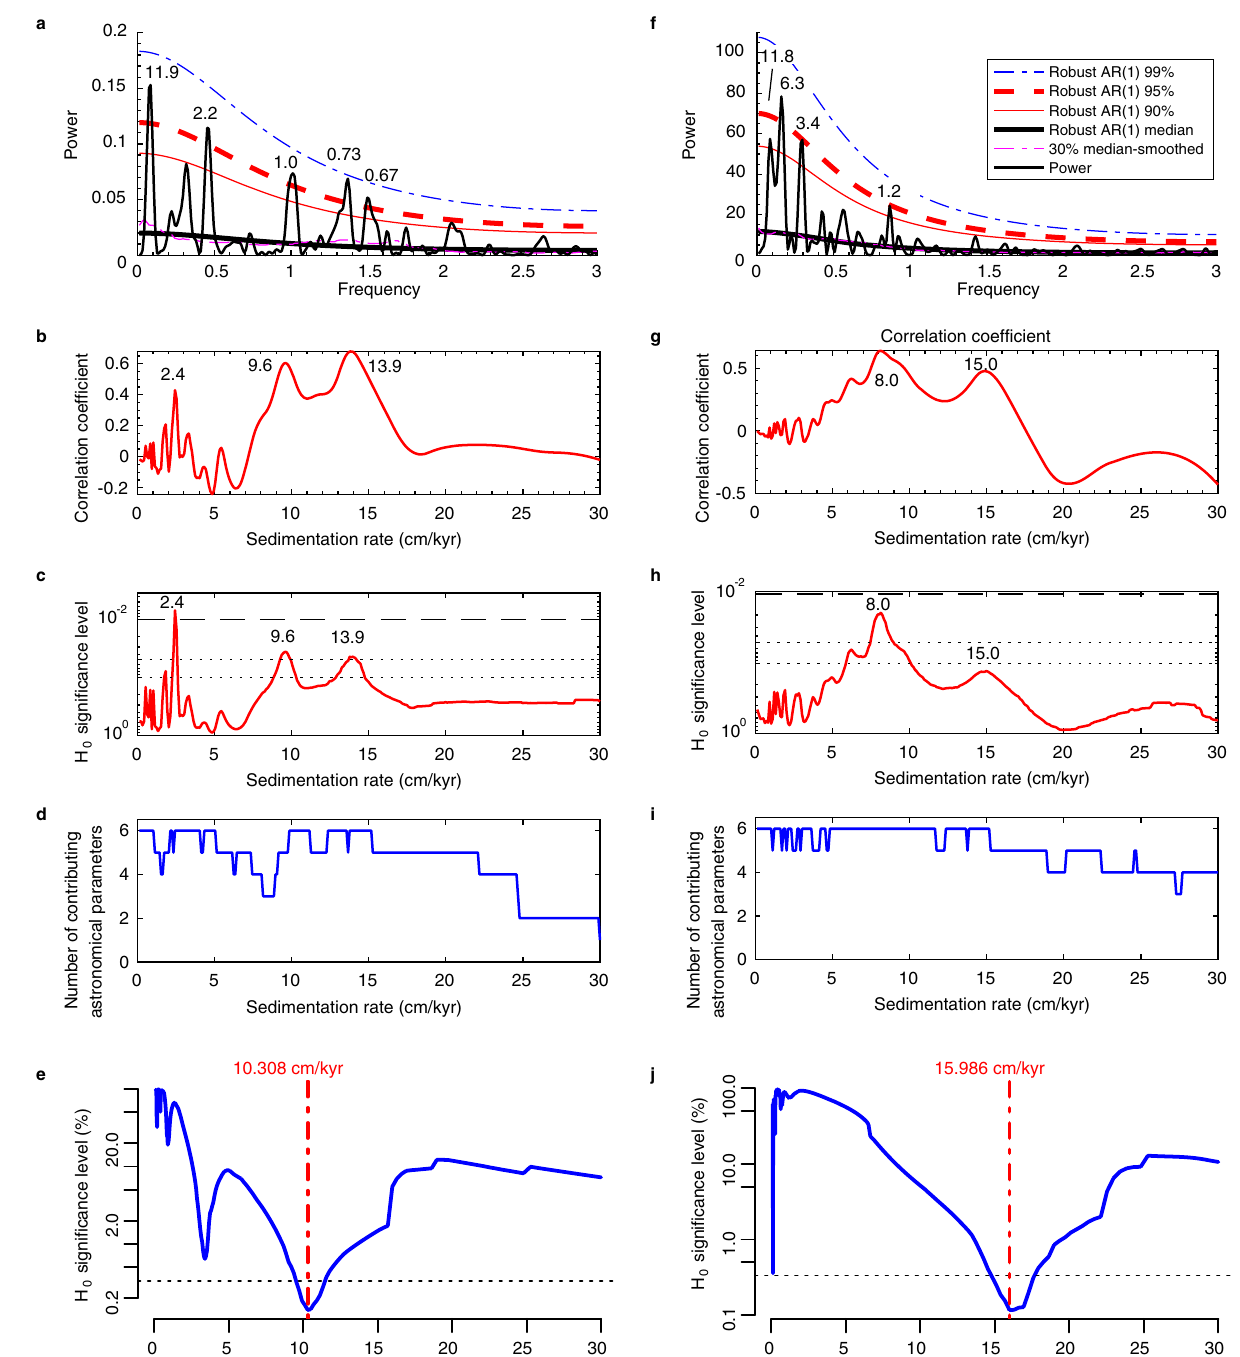
Fig. 4 | Spectral analysis and sedimentation rate evaluation of the log 10 (Ca) (a – e) and magnetic susceptibility (MS) (f – j) series. a , f Lomb-Scargle spectra of the detrended log 10 (Ca) ( a ) and detrended MS ( f ) series shown with con fi dence levels test against robust fi rst-order autoregressive AR(1) red noise models. Sig- ni fi cant periodicities are labeled with the unit of meters. The 1-slice correlation coef fi cient (COCO) spectra of the detrended log 10 (Ca) ( b – d ) and detrended MS